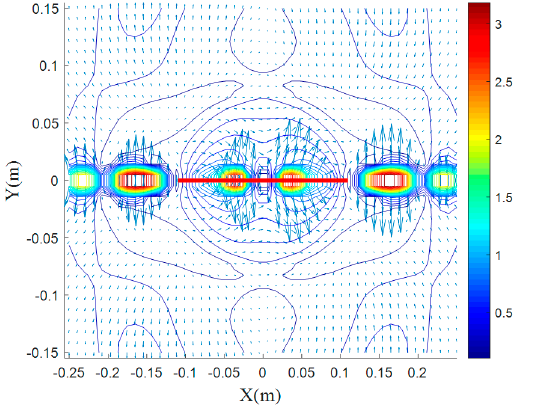
μ with 253 . == εε and 1 = μ , in the XY, z tz t